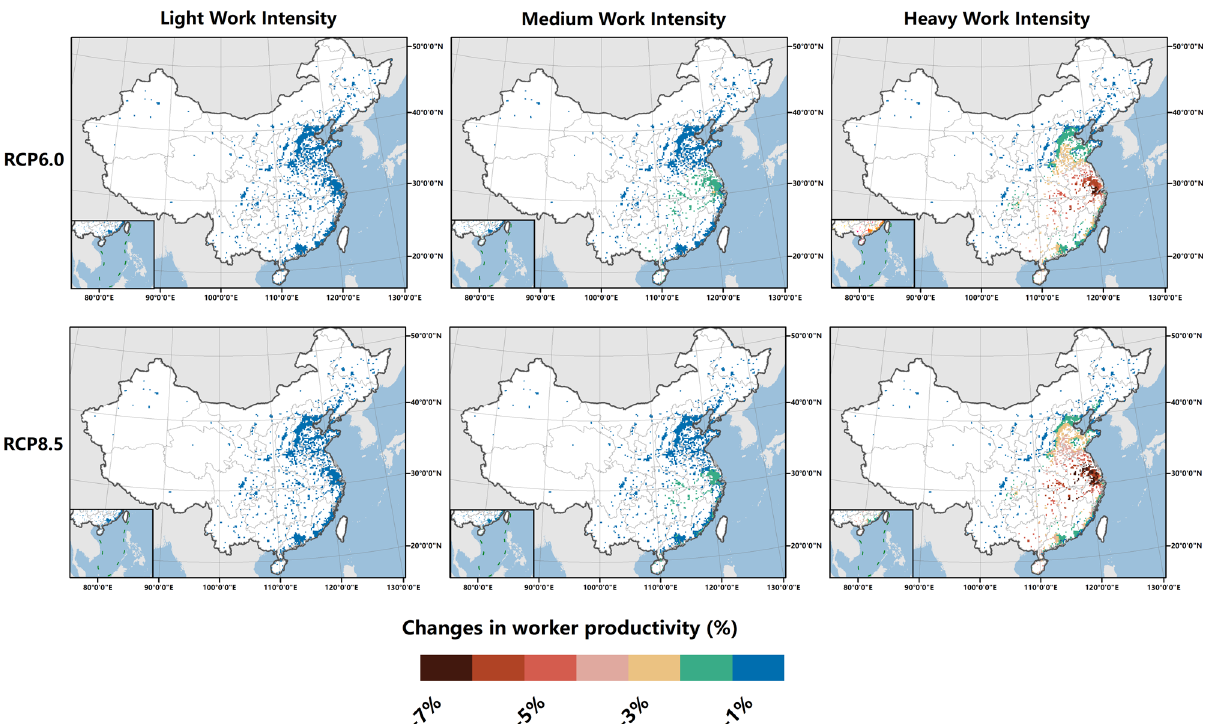
Fig. 3 Average reduction in the hourly worker productivity for three types of work activities during summertime by the 2050s relative to the 2010s. We use the exposure – response function developed by Kjellstrom 11 to estimate the heat impacts on the hourly labor productivity during all possible work hours in summer. For the calculation process, please refer to the Methods